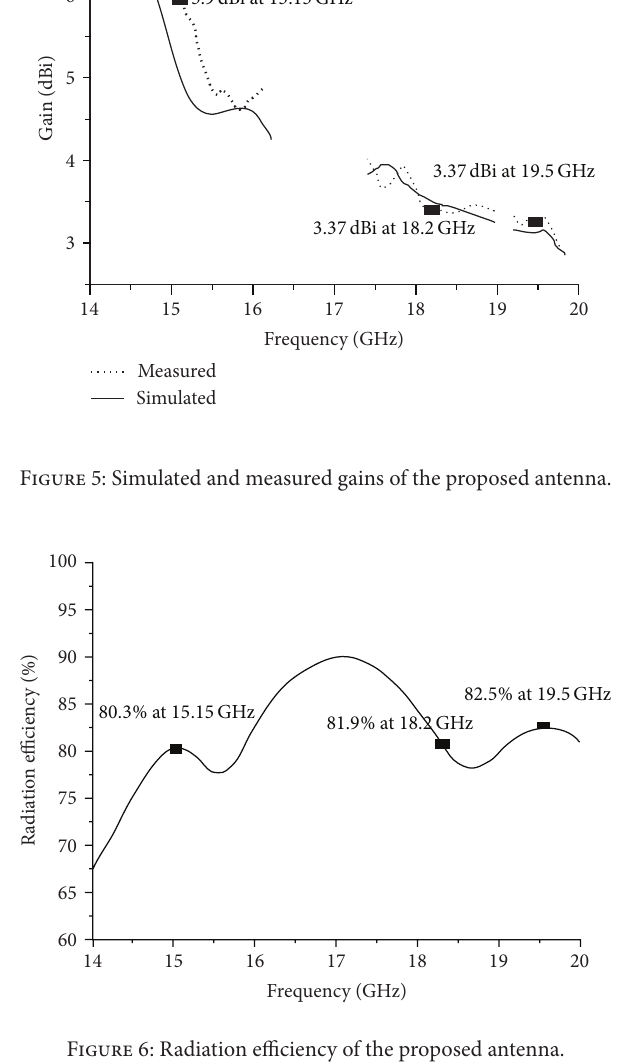
Figure 6: Radiation efficiency of the proposed